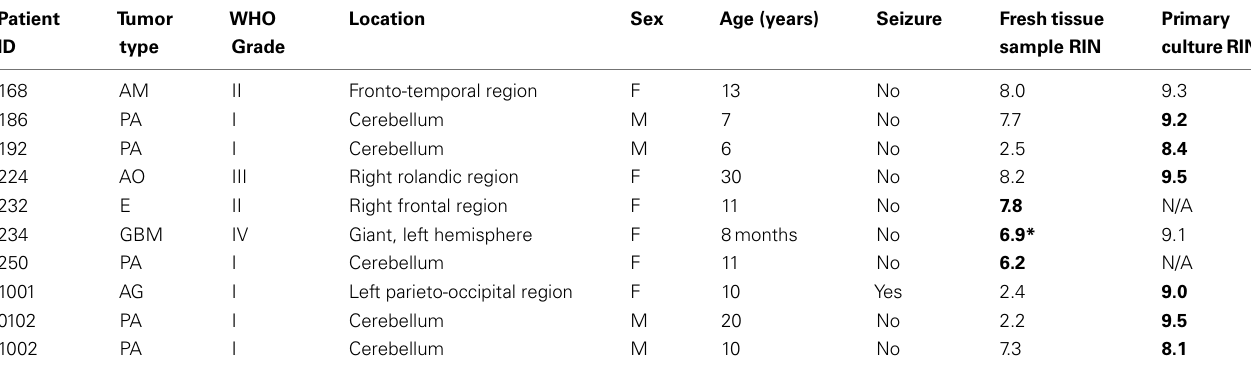
Table 1 | Characteristics of tumor samples included in the